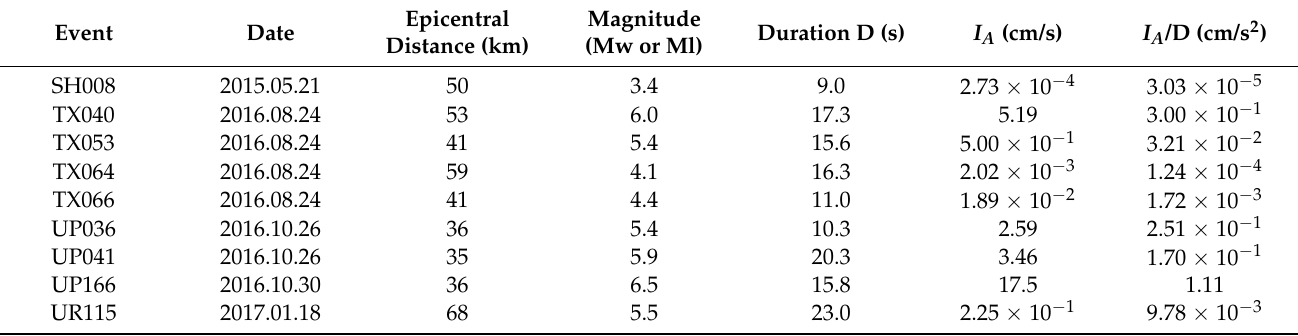
Table 2. Data of the selected seismic